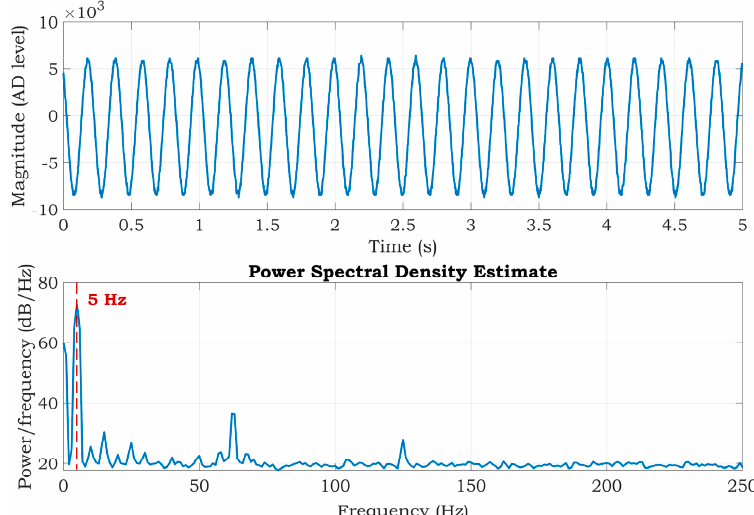
Figure 5. The first 5 s of the output signal (top) and Power Spectral Density (PSD) estimate (bottom) of the three-electrode system with an enabled DRL circuit.